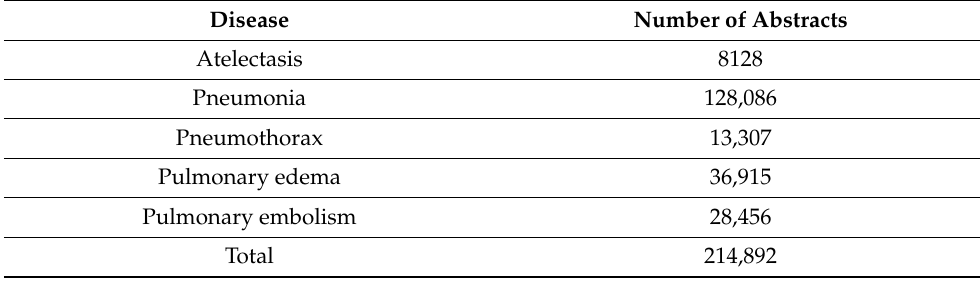
Table 1. Number of abstracts for each disease. Disease Number of